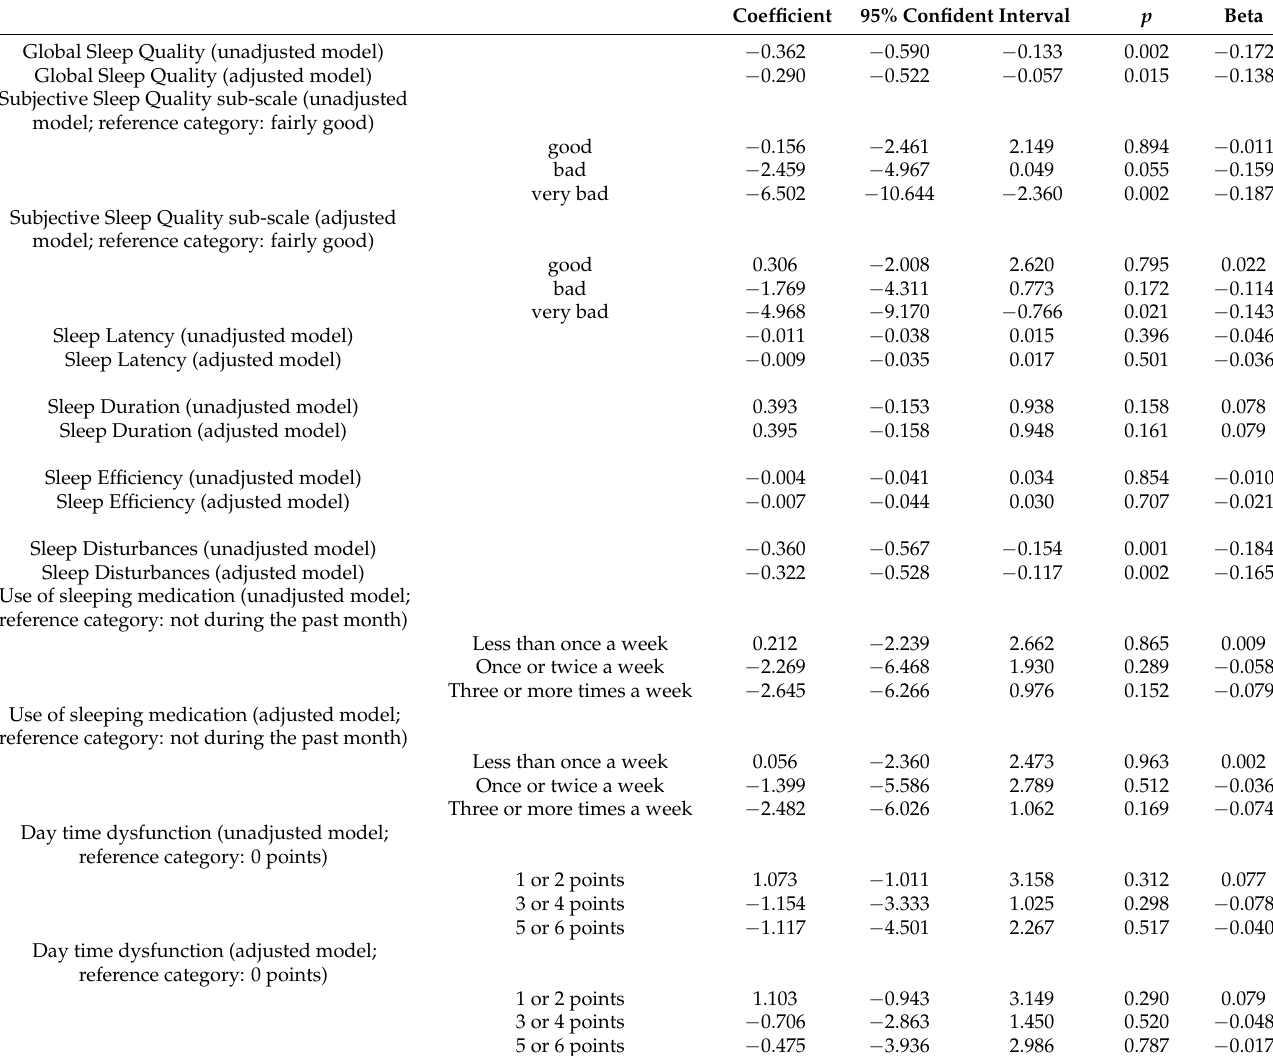
Table 2. Sleep quality and physical health (outcome variable: physical